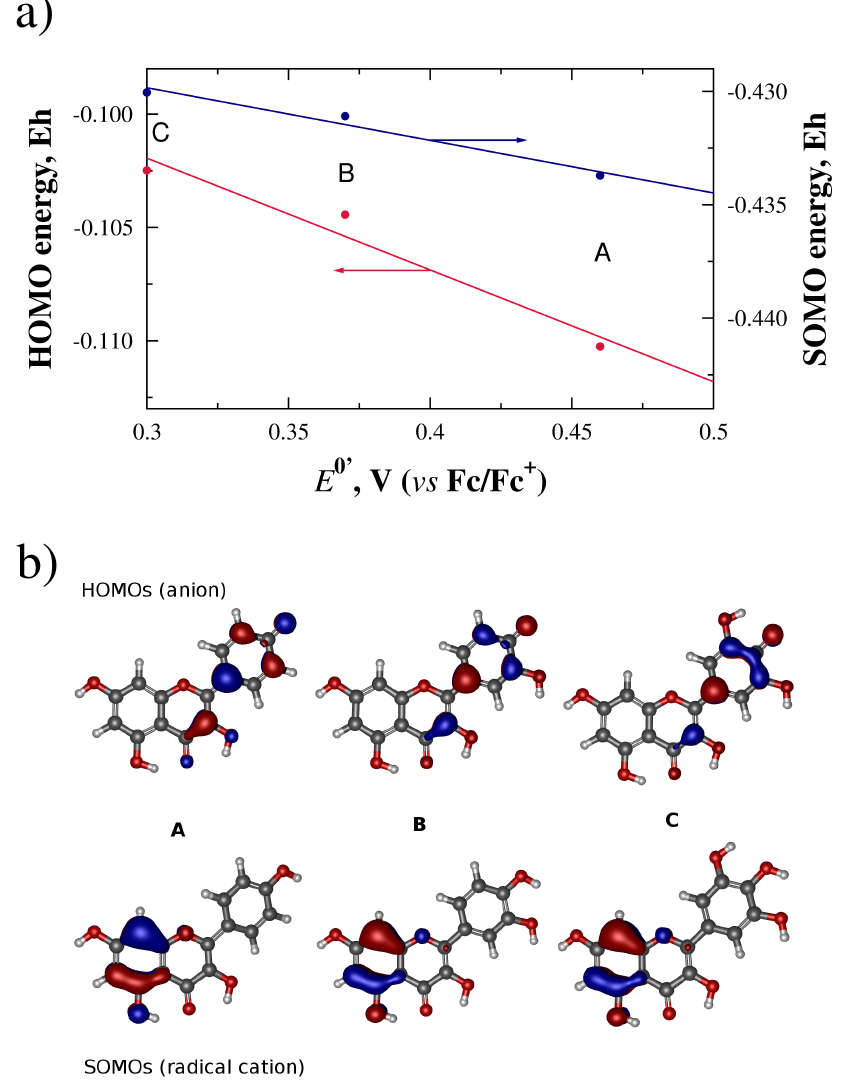
Figure 4. ( a ) linear correlations between E (cid:48) potentials, in Volts, and molecular orbital energies for 0 the HOMO of the deprotonated flavonols (anion) and the SOMO for the radical cation, in Hartrees; ( b ) HOMOs and SOMOs for flavonols kaempferol (A), quercetin (B), and myricetin (C) obtained at the HF/SVP level of